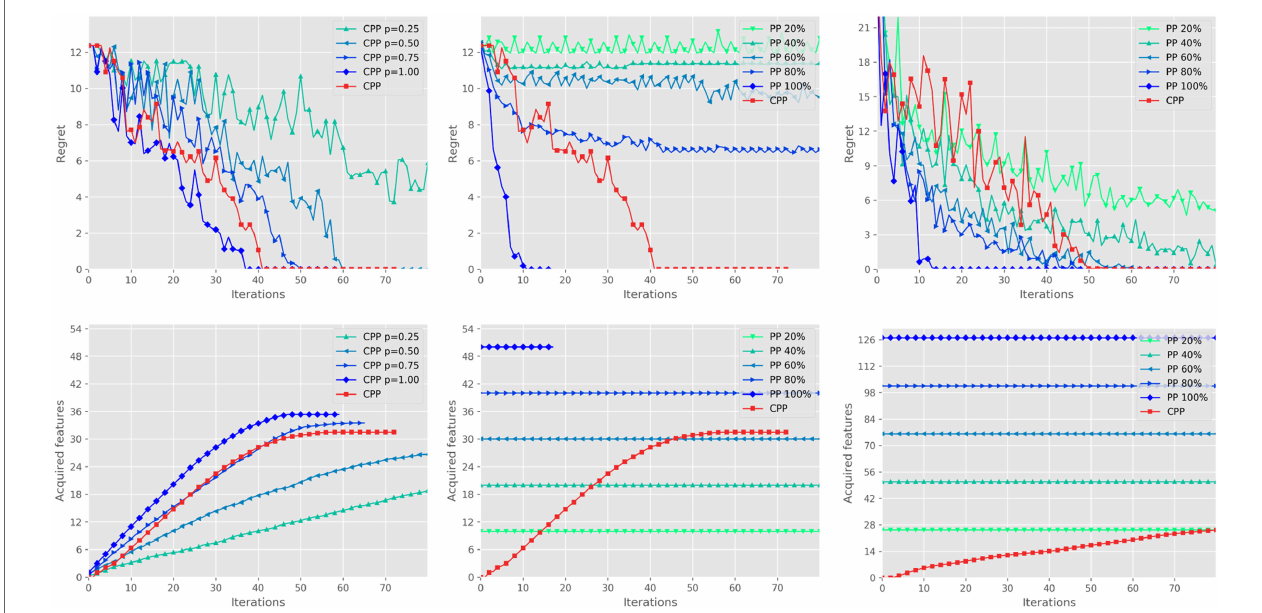
FIGURE 7 | Left: Comparison of CPP for different choices of NC procedure; median utility loss at the top, average number of acquired features at the bottom. Middle: Comparison between CPP and PP on the synthetic problem. Right: Comparison between CPP and PP on the trip planning problem. Best viewed in